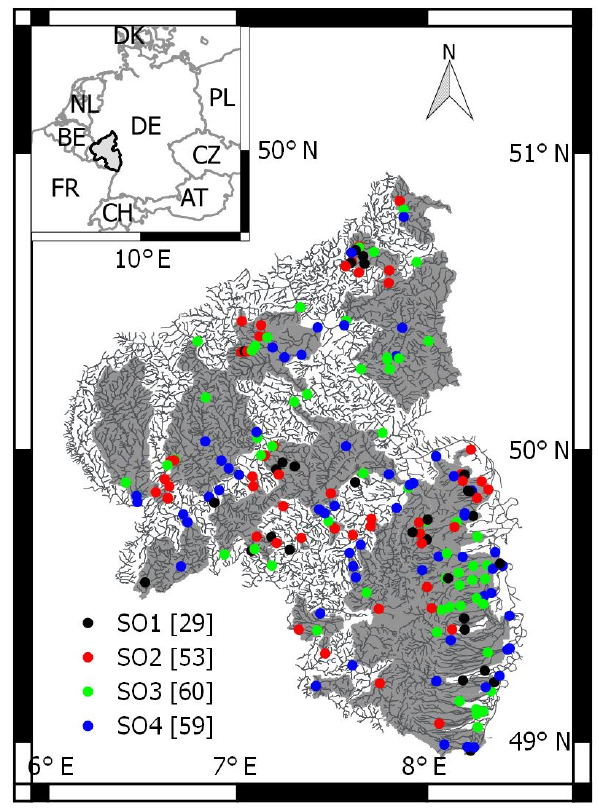
Figure 1. Map of the stream network (black lines) within the state borders of Rhineland-Palatinate in southwest Germany. The inset map in the upper left corner indicates the location of the study re- gion in central Europe. Filled circles mark the positions of sampling sites with color indicating stream order (SO1–SO4; the numbers in brackets in the legend are the respective number of sampling sites). The catchment areas of the sampling sites are marked in